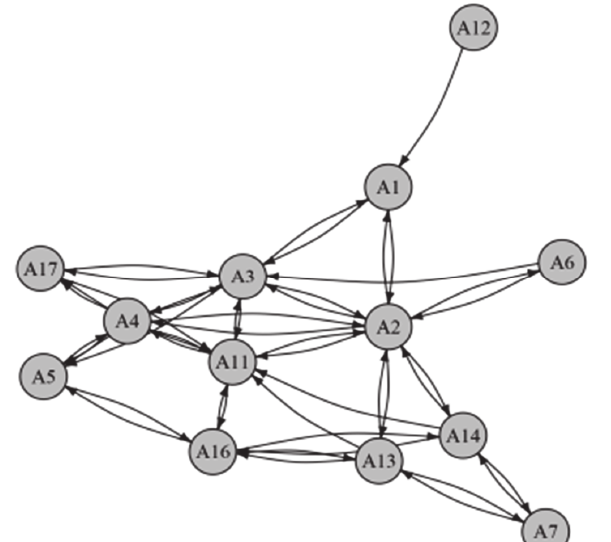
Fig. 4. Network of influence of information transfer in export logistics chains. Adapted (Durán & Córdova,